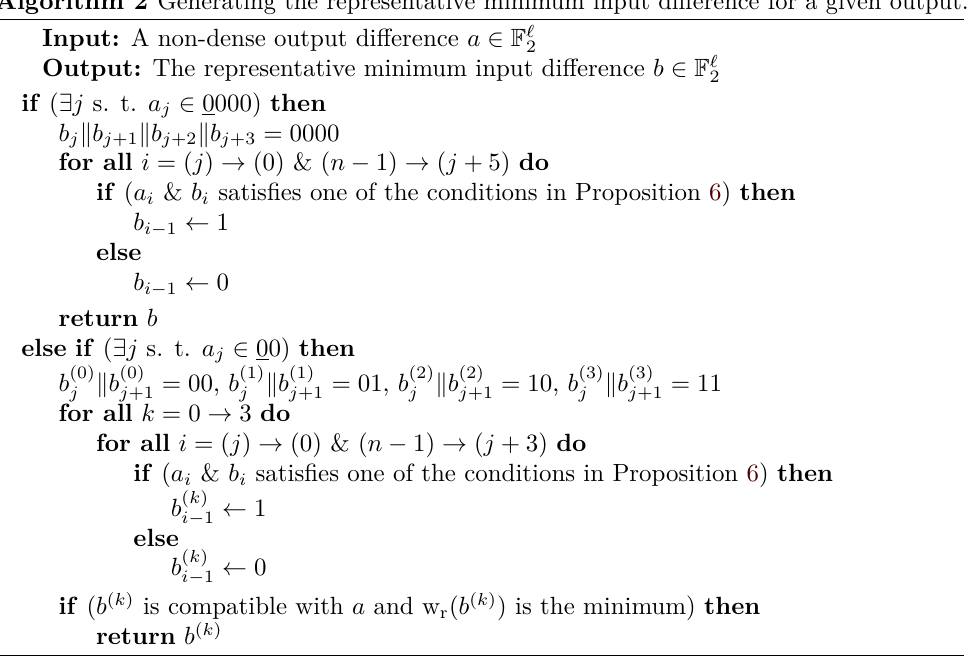
Algorithm 2 Generating the representative minimum input difference for a given